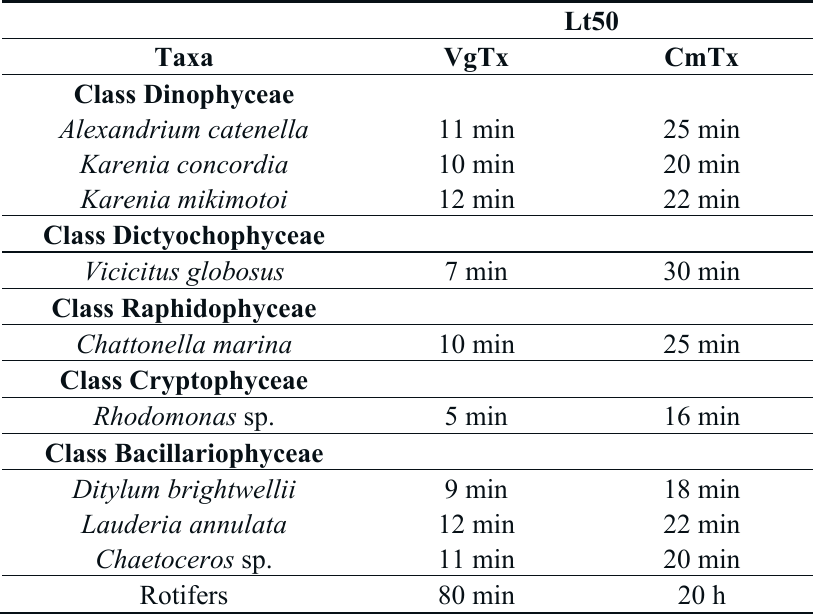
Table 1. Cytotoxic effects of the lipophilic extracts of Vicicitus globosus (strain NIWA 1008) (VgTx) and Chattonella marina (strain NIWA 1022) (CmTx) on three species each of dinoflagellates, three classes of microflagellates, diatoms, and also on rotifers (Lt50 = time taken to kill half the number (50%) of the test